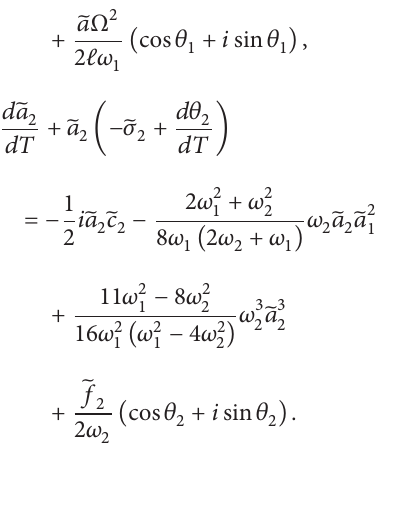
Figure 2: Time history for the solution 𝑥 .